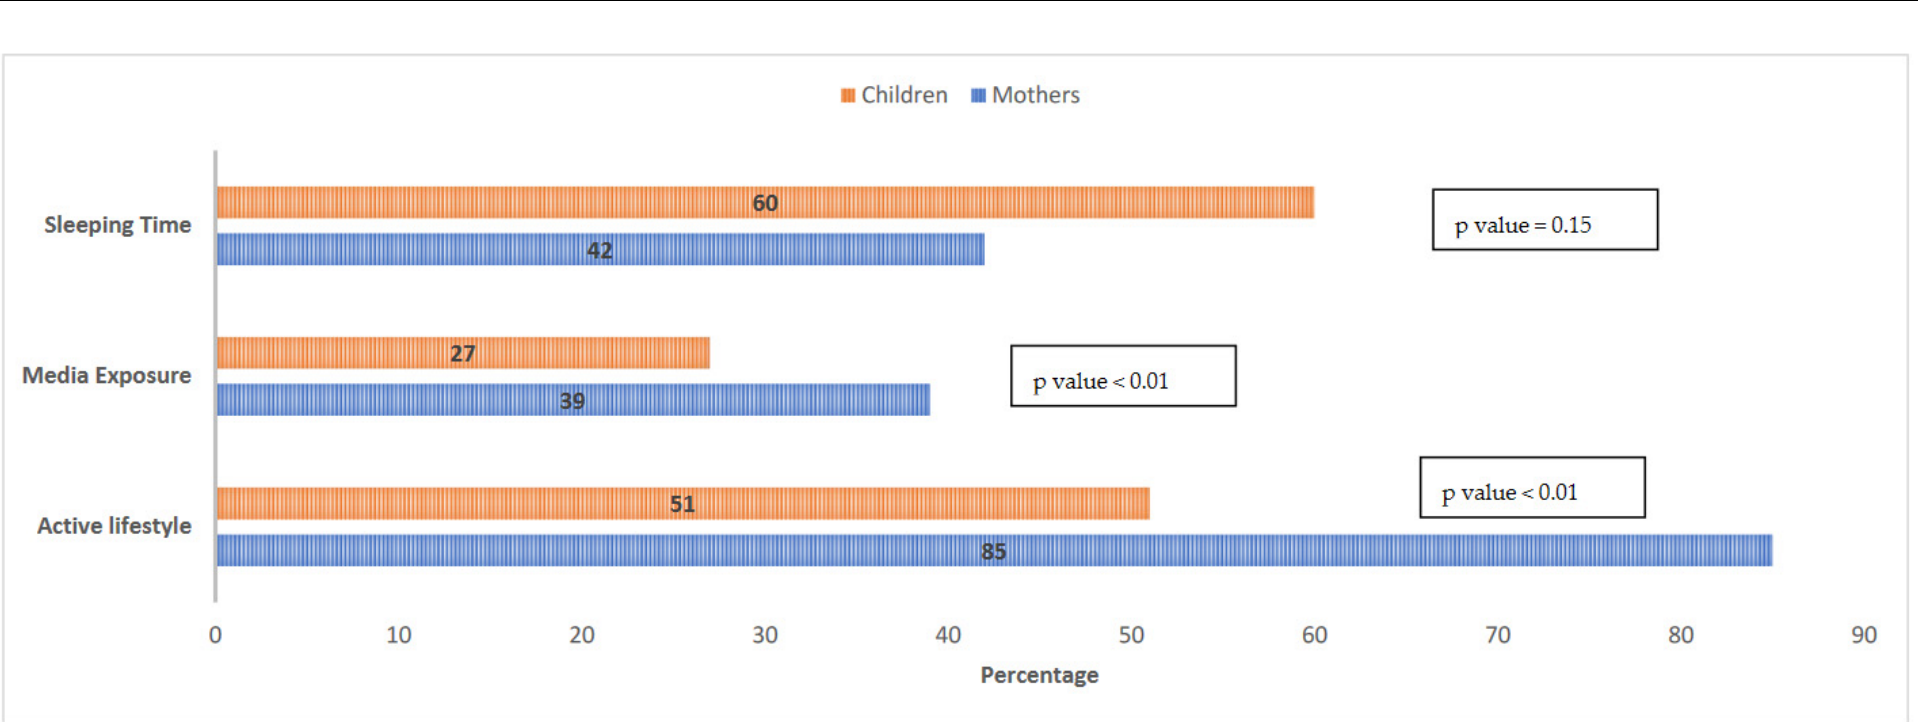
Figure 2. Compliance with Sleeping, Media Exposure and PA guidelines among Mothers and Children. p -values represent differences between mothers and children calculated using the independent t test.